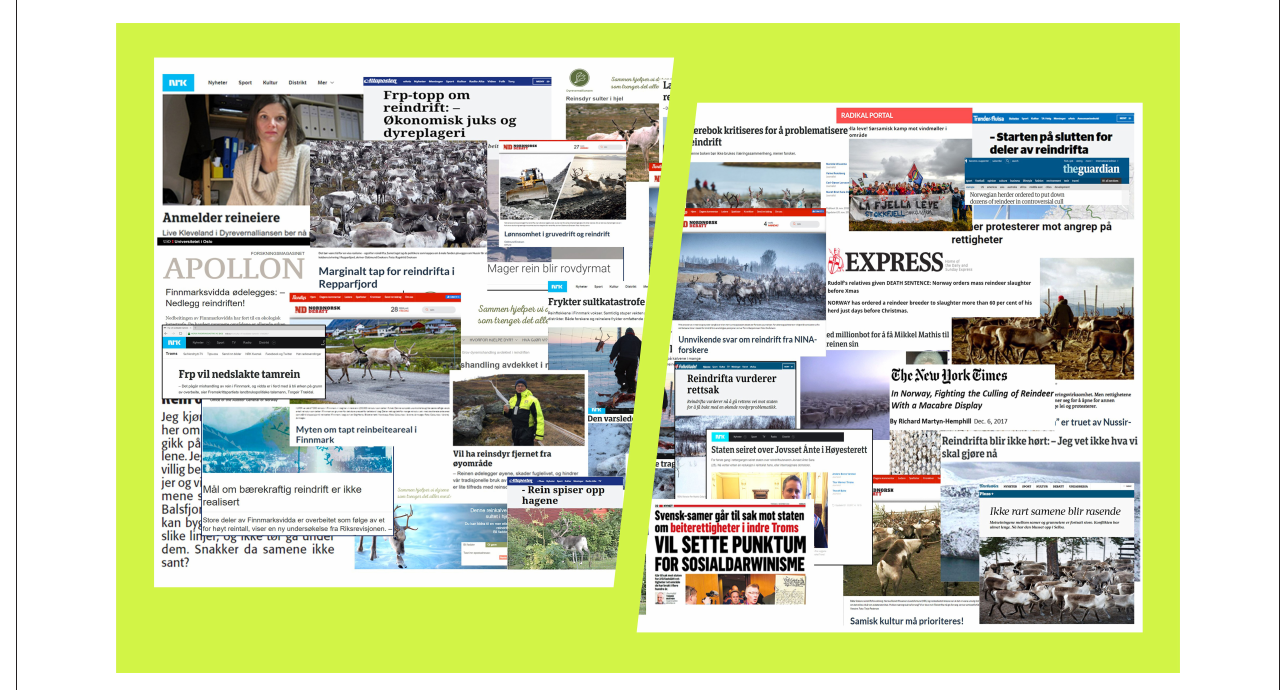
FIGURE 5 | Divided discourse: a selection of cuttings illustrating contrasting opinions about reindeer pastoralism in Norway. Translations are as follows. On the left : Reports reindeer herders [to the police]; Finnmarksvidda is being destroyed—abolish reindeer husbandry; Senior member of the Progress Party on reindeer husbandry: economic swindle and animal cruelty; Reindeer starving to death; Marginal loss… [of reindeer pasture owing to mining at] Repparfjord; Thin reindeer